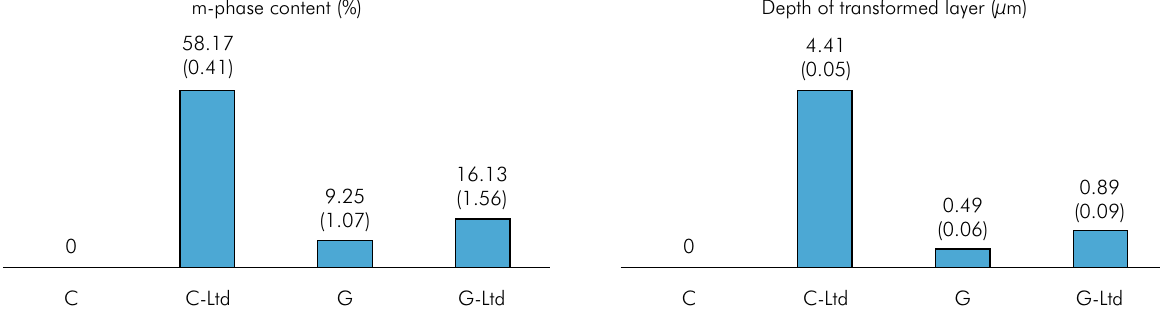
), Weibull modulus (m) c